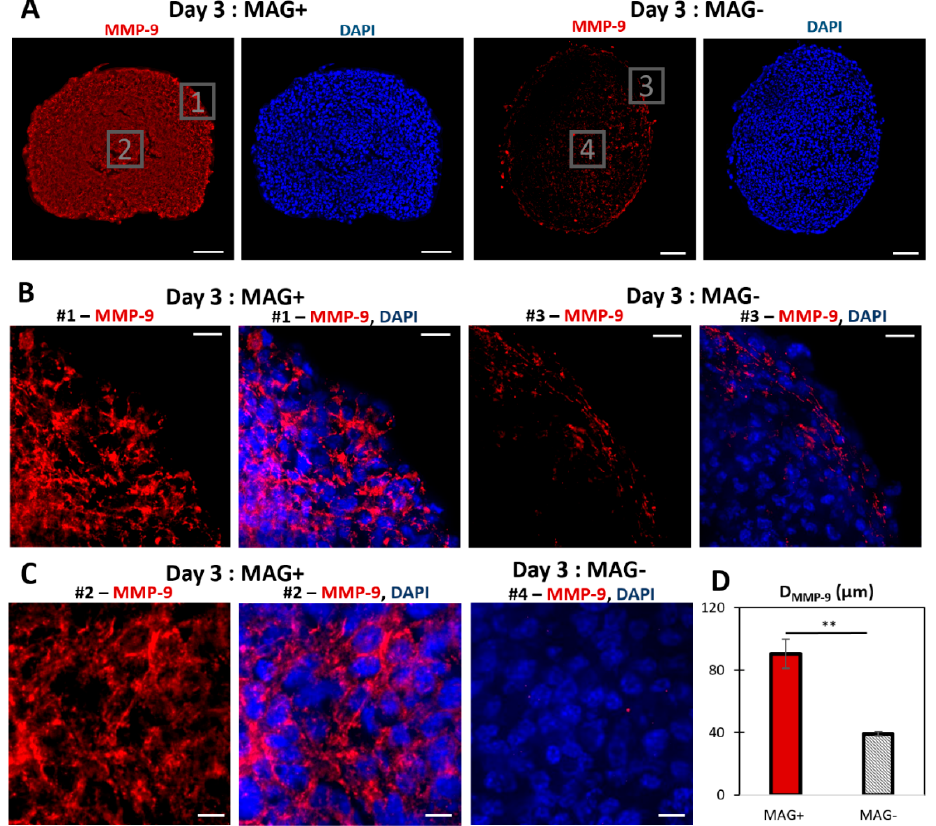
Figure 4. MMP − 9 labeling of MAG+ and MAG − spheroids at day 3. ( A ) Typical fluorescent staining of MAG+ and MAG − spheroids cultured for two days after formation. MMP − 9 is labeled in red, and the nuclei are labeled in blue (DAPI). For the MAG − spheroids, MMP − 9 was mostly expressed at the edges. The MAG+ spheroids showed significant MMP − 9 expression toward the center. Scale bar = 100 µm. ( B ) Close up images (# = number) at the edges of the spheroids: MMP − 9 only (red) and merged images (MMP − 9 in red, DAPI in blue). Scale bar = 20 µm. ( C ) Close up images for MAG+ (MMP − 9 only in red and merged image with DAPI in blue) and MAG − spheroids (merged image of MMP − 9 in red and DAPI in blue). Scale bar = 10 µm. ( D ) Localization of MMP − 9 for the two conditions. The maximal radial MMP − 9 localization, from the edges toward the spheroid center was quantified. The average MMP − 9 depth was higher for the three-day MAG+ spheroids (red bar) than for the MAG − spheroids (striped bar), n = 2 and n = 3, respectively (** p < 0.001).